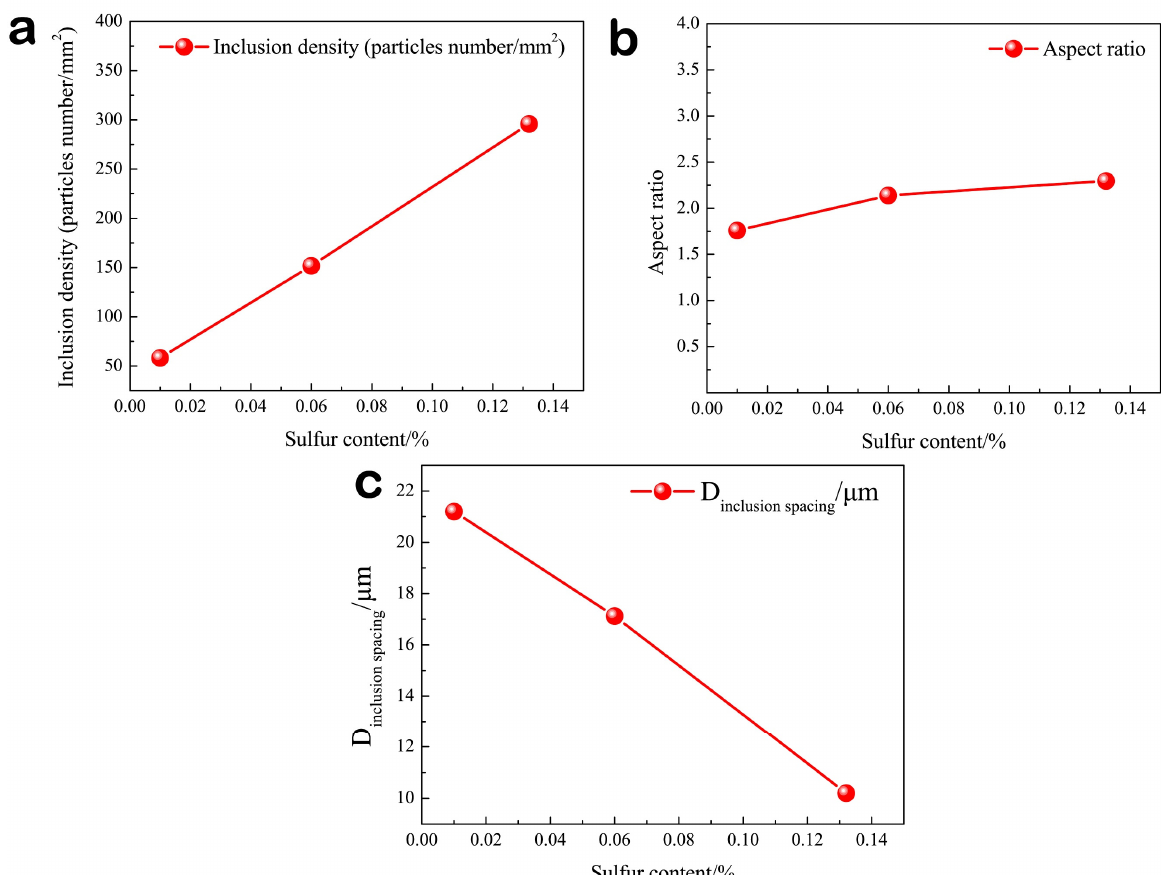
Figure 8. Inclusion density, aspect ratio and D inclusion spacing in Sample S2 of Steel A–C. ( a ) Inclusion density. ( b ) Aspect ratio. ( c ) D inclusion spacing . density. ( b ) Aspect ratio. ( c ) D inclusion spacing